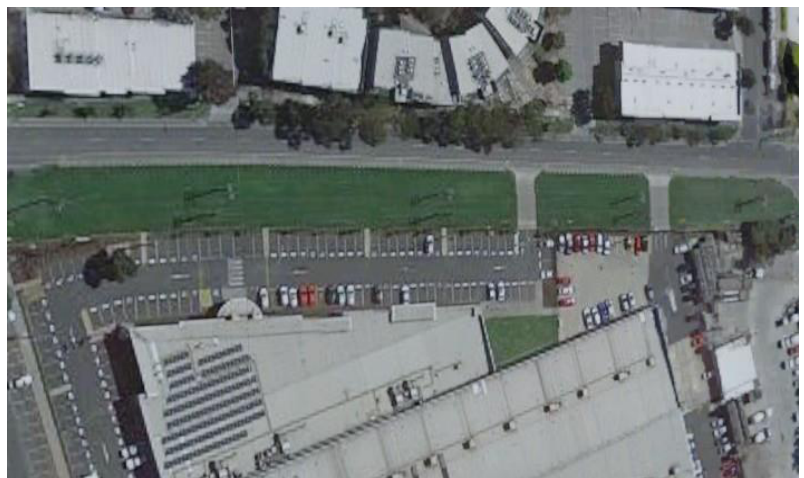
Figure 3. Turner Street reality model.